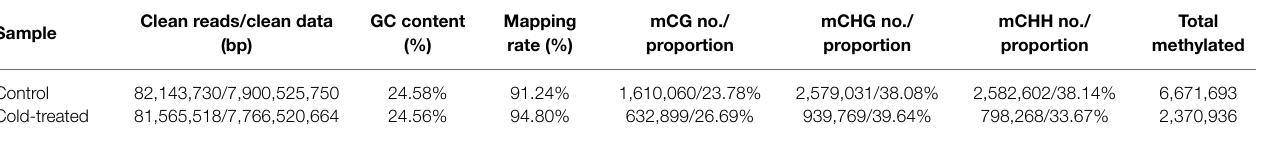
TABLE 1 | Reduced representation bisulphite sequencing (RRBS)